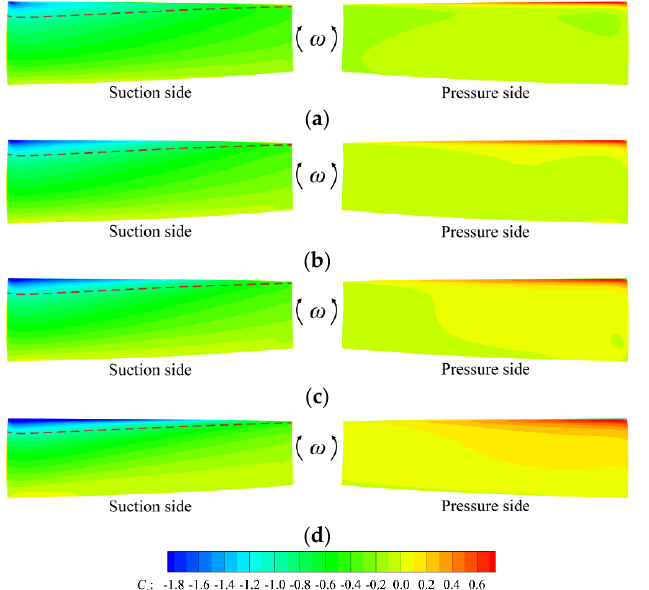
Figure 12. Pressure coefficient contours on blade surfaces at different heights: ( a ) OGE; ( b ) h/D = 1.5; ( c ) h/D = 1.0; ( d ) h/D = 0.5.